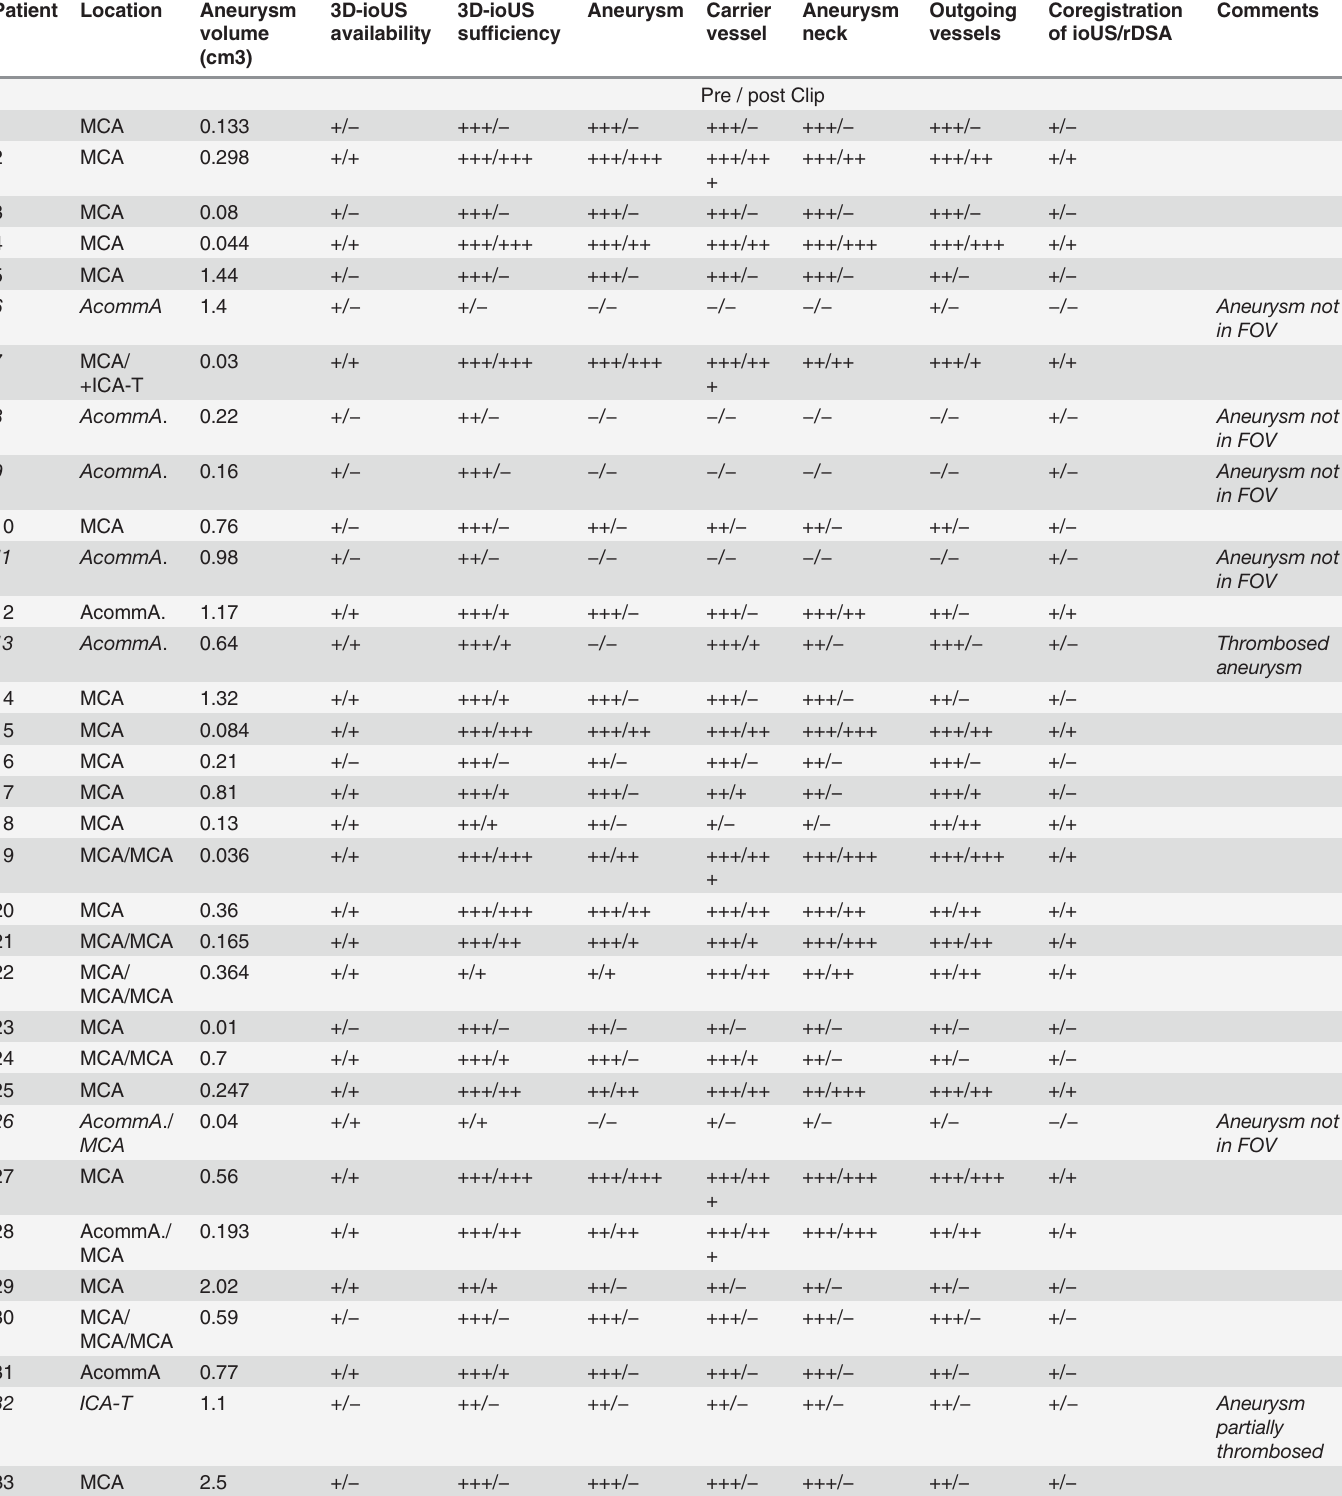
Table 1. Evaluation of